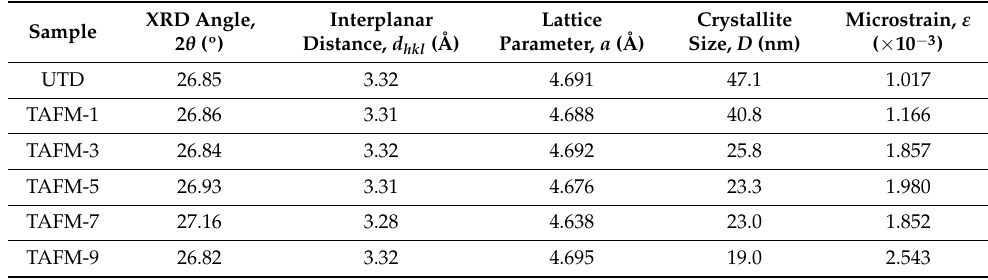
Table 1. Structural properties of the prepared samples analysed from XRD patterns.